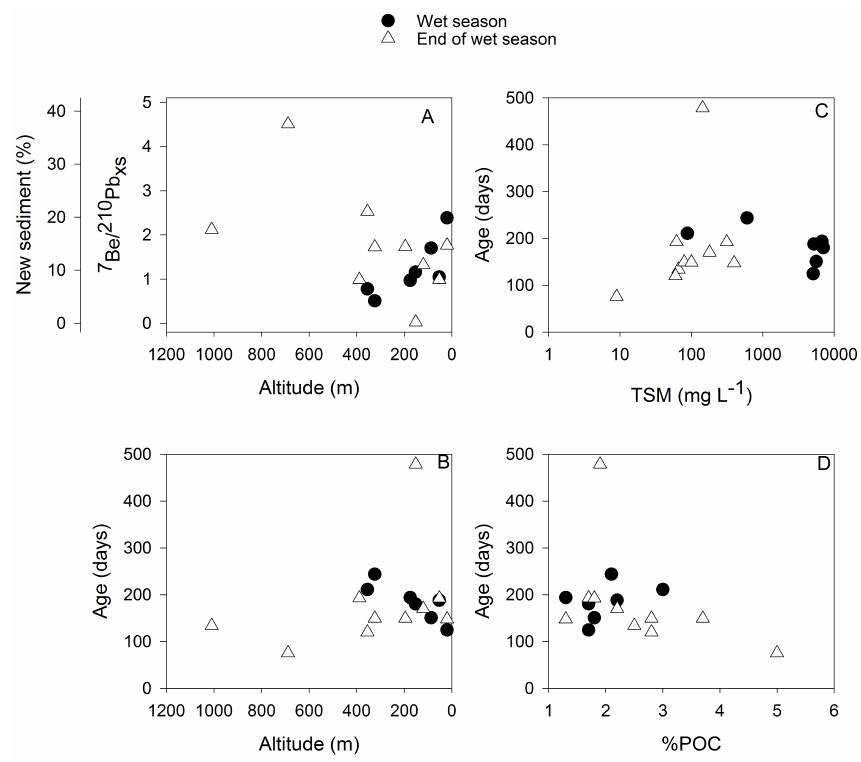
Fig. 10. Overview of results of 7 Be/ 210 Pb xs measurements on suspended sediment samples in the Tana River during wet season and end of wet season: (A) altitudinal profile of 7 Be/ 210 Pb xs ratios, and the estimated % new sediment, (B) altitudinal profile of the estimated suspended matter age, (C) relationship between suspended matter age and TSM concentrations, and (D) relationship between suspended matter age and